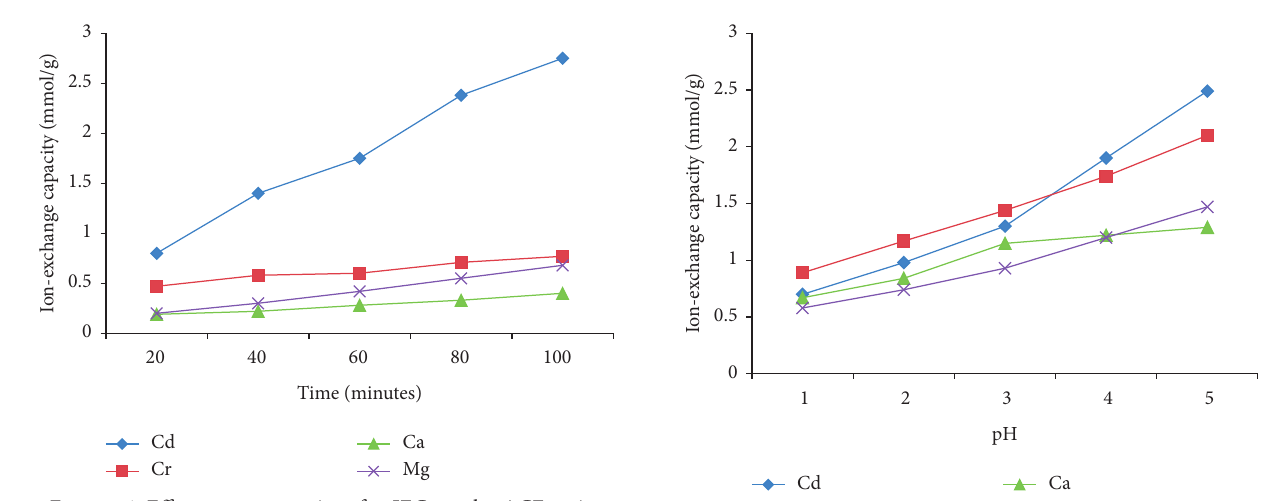
Figure 6: Effect on contact time for IEC on the ACF resin.